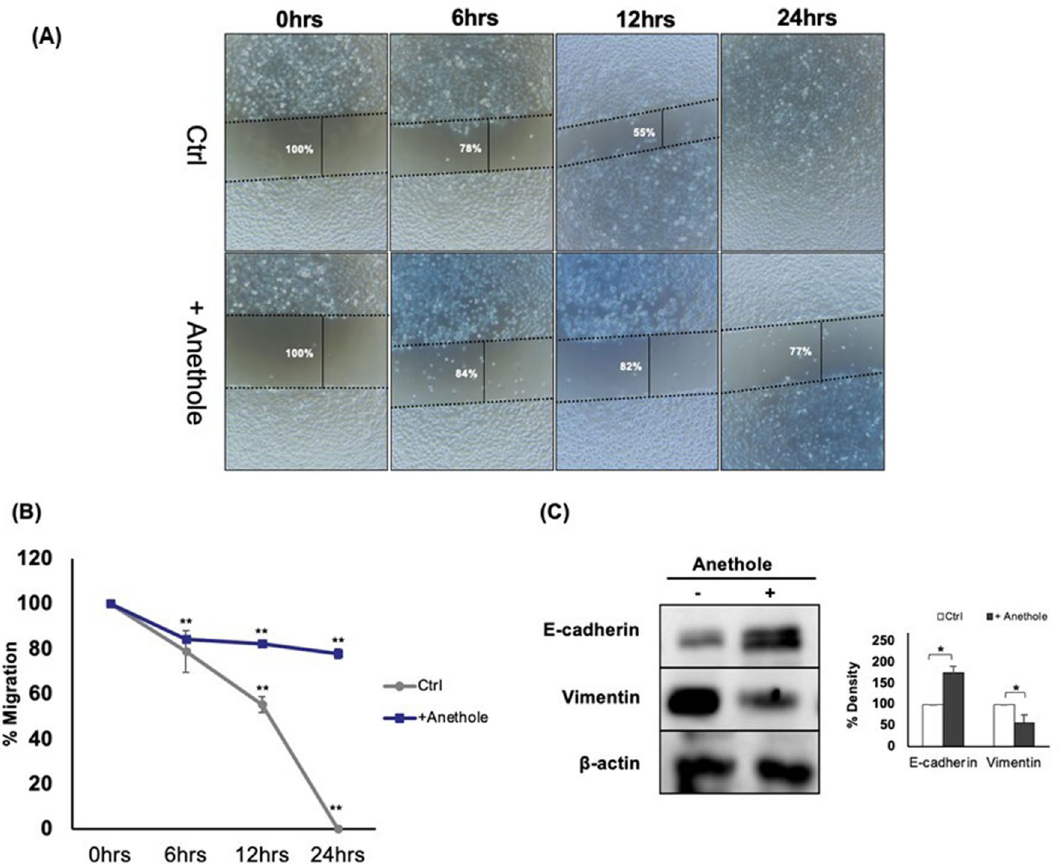
Figure 3. Anethole inhibits the migration of oral cancer cells. ( A ) Mouth epidermoid carcinoma cells (Ca9-22) were cultured up to 100% confluence. Scratches were then made on each monolayer and cells were incubated with or without anethole. Cell migration/wound repair were observed over time (0, 6, 12 and 24 h) and pictures were taken. Wound closure was measure by the distance, at 3 separate sites, between opposite edges of it. Results are reported as the means (%) ± SD (n = 3). ( B ) Graphs displaying the three experiments of a cell lesion assay on Ca9-22 incubated with or without anethole 3 μM. ( C ) Western blotting of E-cadherin and vimentin after being exposed for 24 h, with or without anethole (10 μM) (n =